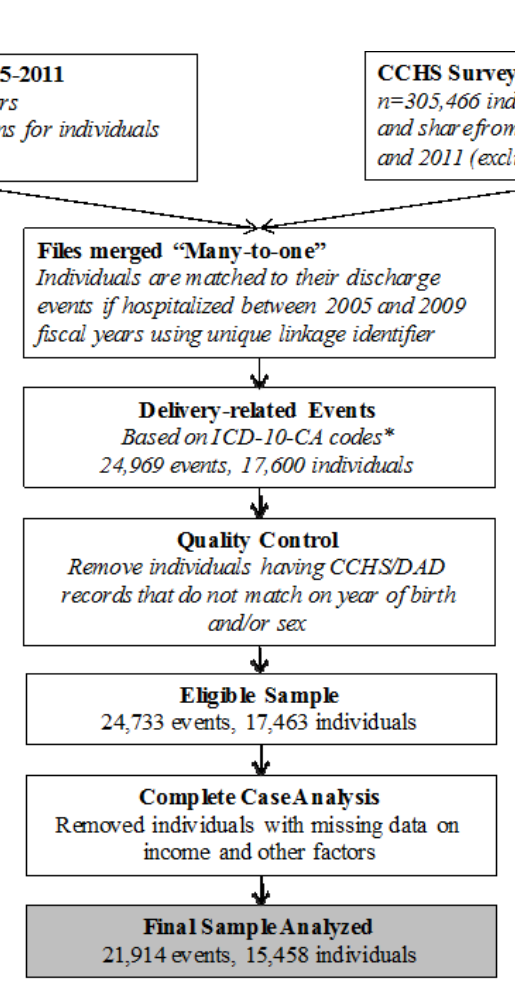
Supplementary Figure 3: Flow chart detailing the sample selection approach for complete case analysis of delivery-related